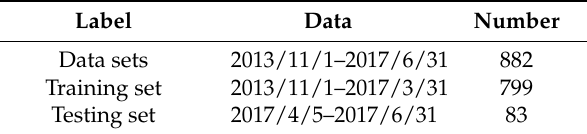
Table 7. The data sets of